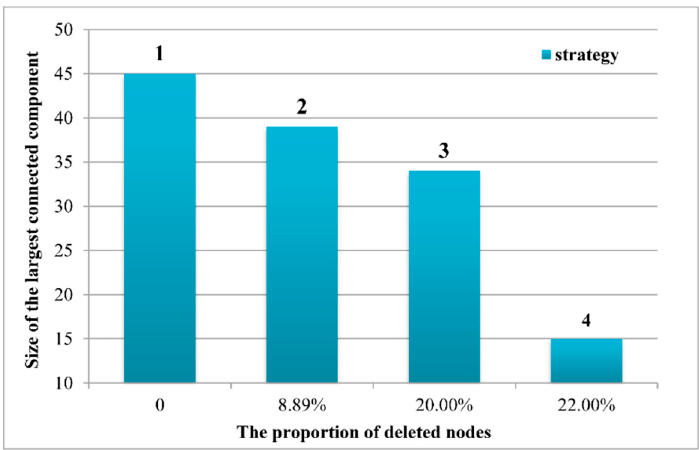
Figure 10. The sensitivity of nIFMA under different removal strategies.